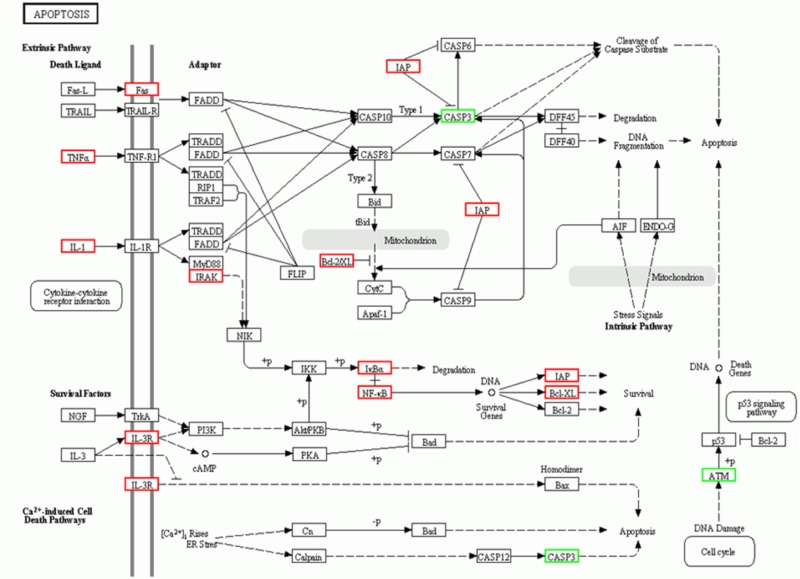
KEGG signaling pathways of apoptosis in cardiomyocytes. The analysis of differential genes were performed between QX1 treated group (high dose, 1 g/kg⋅bw) and CLP surgery group. Up-regulated genes (p < 0.05) were marked with red borders while down-regulated genes (p < 0.05) with green borders.